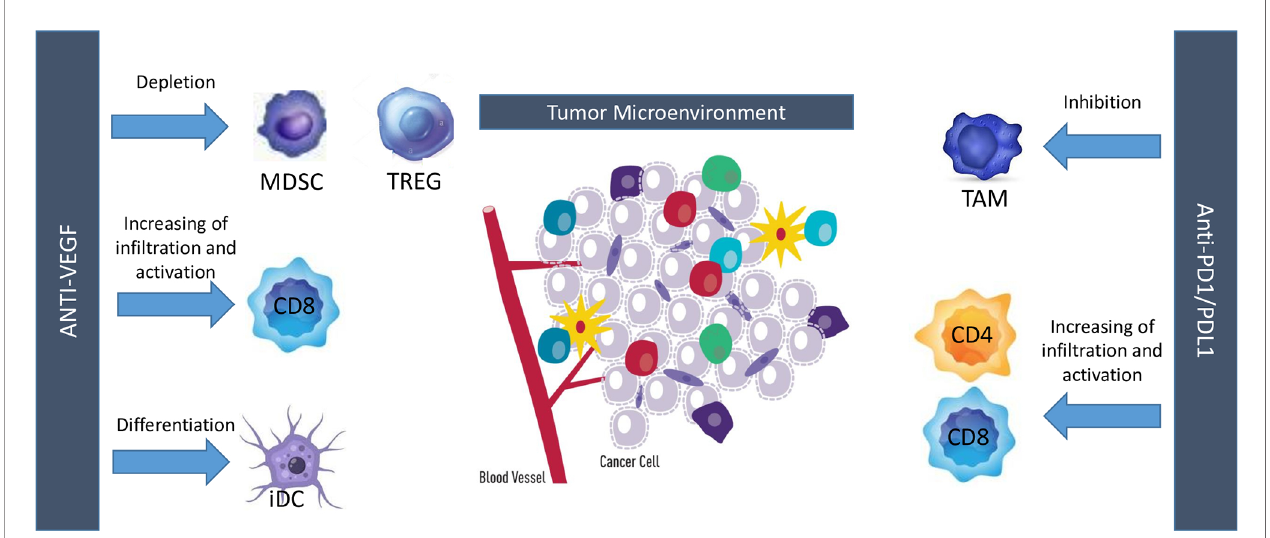
FIGURE 1 | Interactions between angiogenesis and immune-checkpoint inhibitors. MDSC, myeloid-derived suppressor cell; TREG, T regulatory cells; iDC, inhibitory dendritic cells; TAM, tumor-associated macrophages.